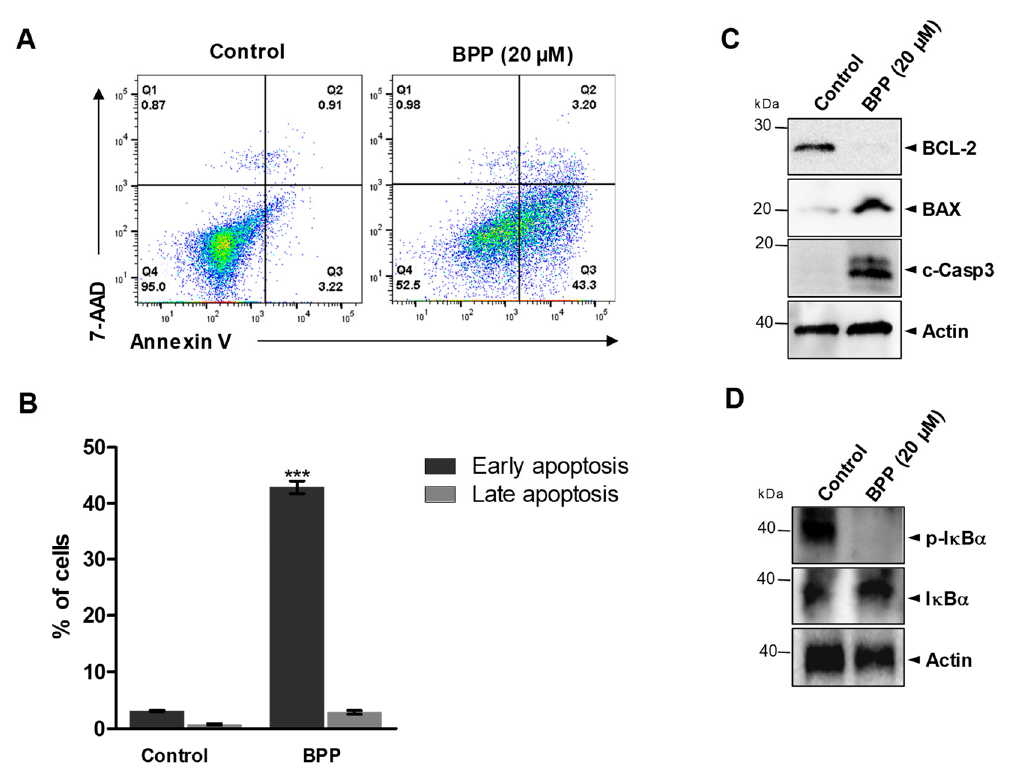
Figure 2. BPP-induced apoptosis in RKO cells. ( A ) RKO cells were compound-untreated or -treated, and apoptosis was evaluated 48 h later using annexin V / 7AAD double staining. Cell death was assessed by flow cytometry. ( B ) Quantification of the early and late apoptotic cell rates. ( C ) Whole cell lysates from BPP-treated cells were immunoblotted with antibodies specific for BCL-2, BAX, and caspase-3 proteins. ( D ) Whole cell lysates were used to determine the expression levels of I-kappa-B-alpha (I κ B α ) and p-I κ B α after treating the cells with BPP (20 µ M).